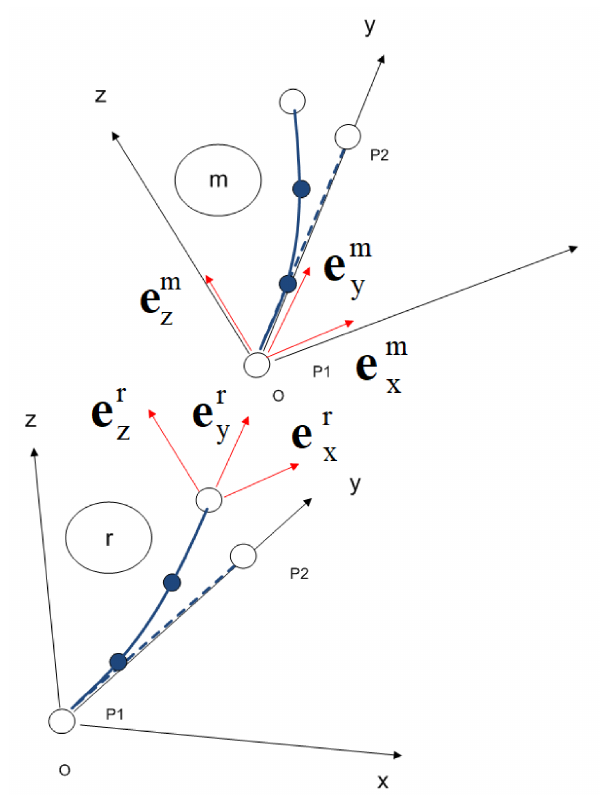
Figure 2. Local bases vectors of interconnection